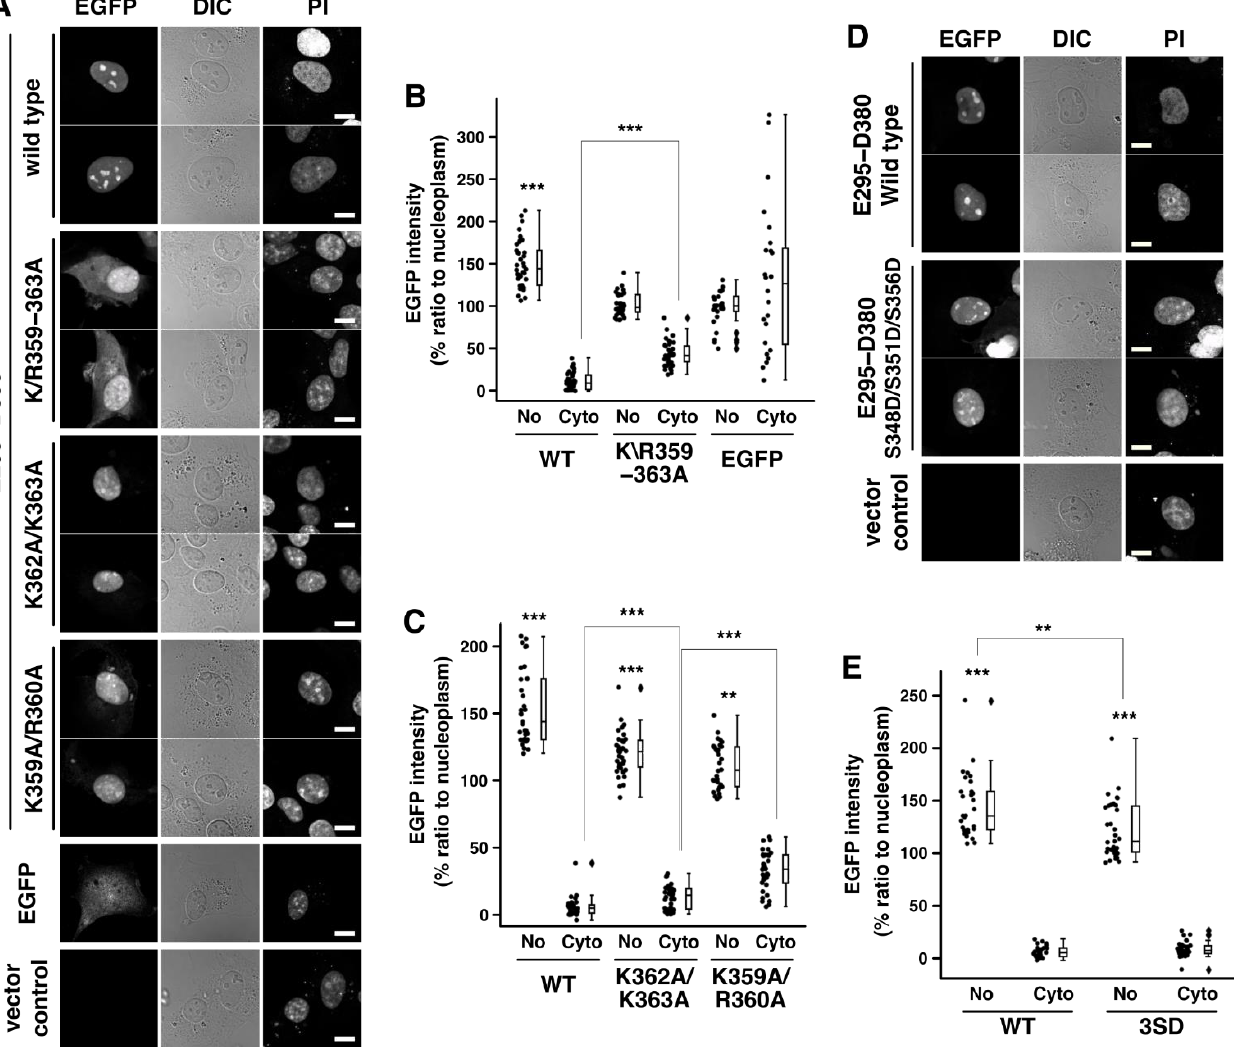
Figure 2. Rad17 K359‒K363 residues encode the nucleolar localization signal. ( A ‒ C ) Nucleolar accumulation of EGFP-Rad17 E295–D380 was abolished by K/R359–363A (A, B, S1A, S1B) and K359A/R360A (A, C, S1D, S1E) mutations. COS-1 cells were transfected with EGFP-Rad17 E295–D380 and fixed 48 h after transfection. DNA was stained with propidium iodide (PI). EGFP signal intensity was quantitated in the nucleolus, the nucleoplasm, and the cytoplasm, and the ratio to the nucleoplasm was calculated. ( D,E ) S348D/S351D/S356D (3SD) mutation abolished the nucleolar accumulation of EGFP- Rad17 E295‒D380. The graph shows representative results of more than three independent experiments. Details of p- value calculation are shown in Figure S1. No, nucleolus. C, cytoplasm. DIC, differential inference contrast. ***, p < 0.001. **, p < 0.01. Scale bars are 10 μm.